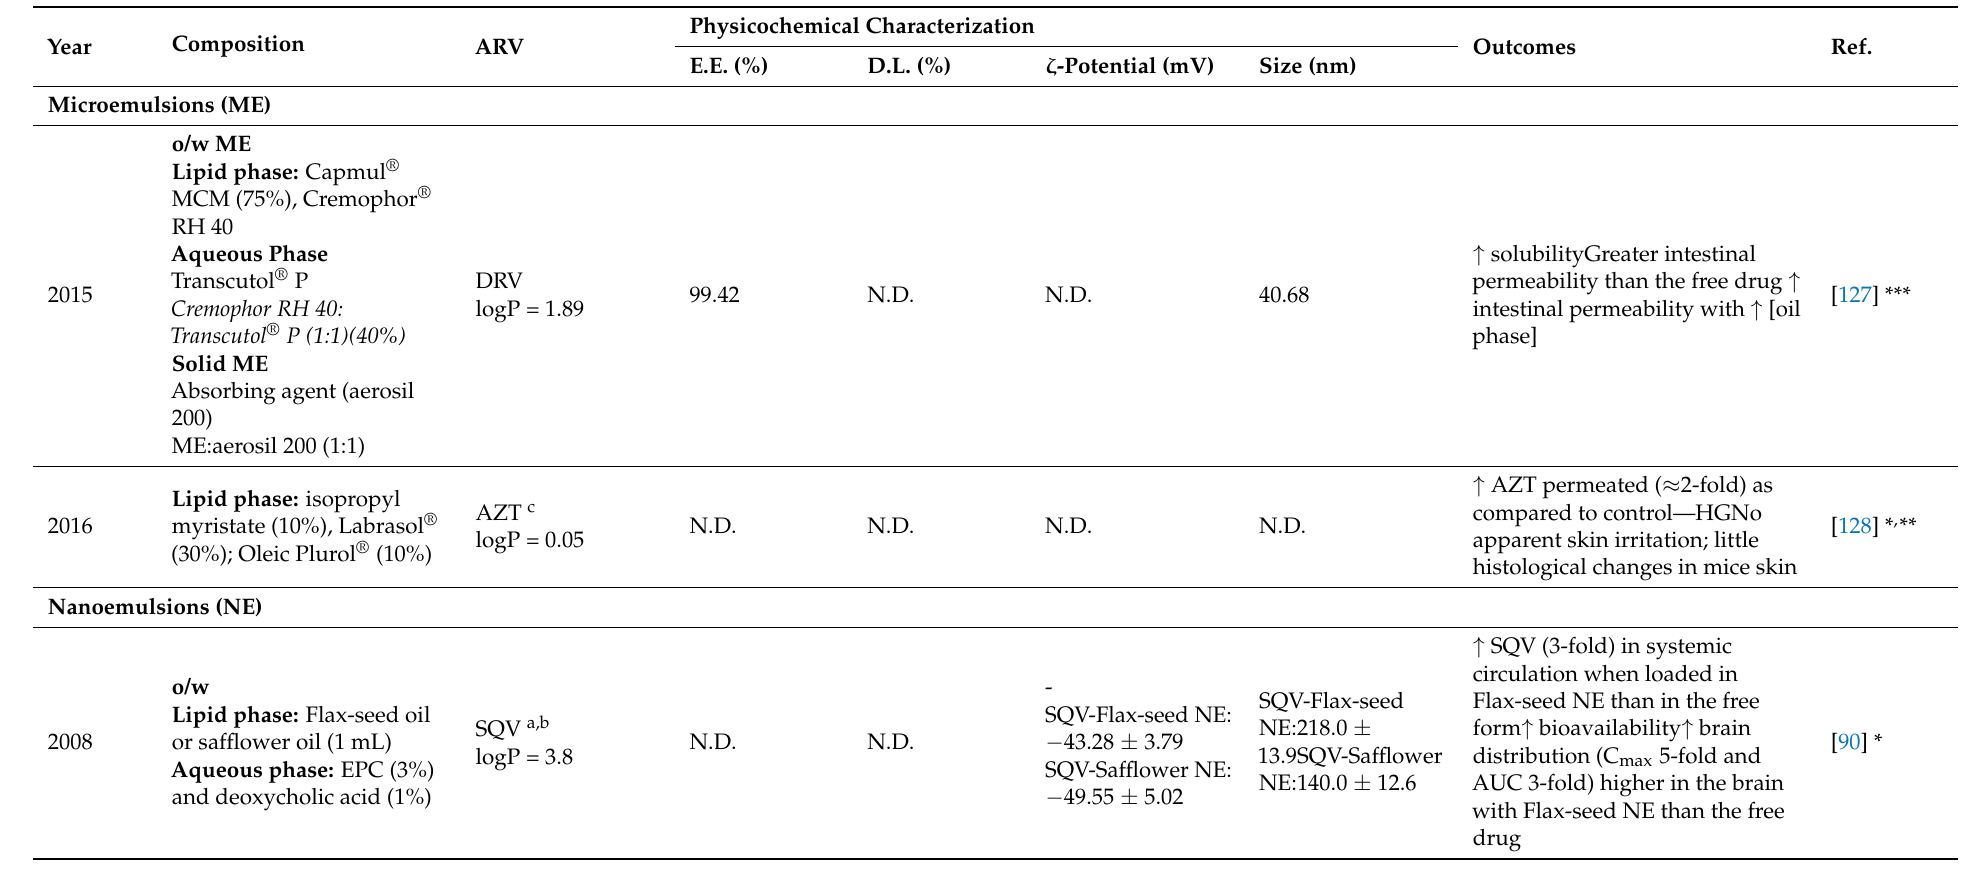
Table 5. Lipid emulsions (microemulsions, nanoemulsions, and self-emulsifying drug delivery systems) for ARV